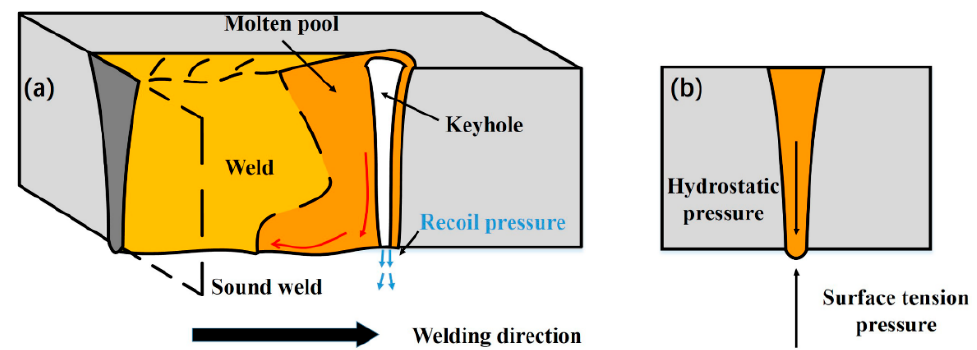
Figure 10. Schematic description of sound weld formation mechanism. ( a ) 3D isometric view; ( b ) Cross-section view